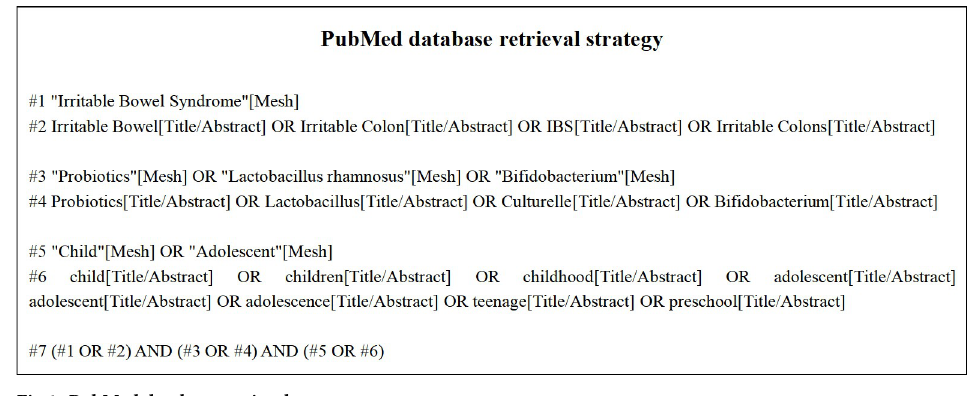
Fig 1. PubMed database retrieval